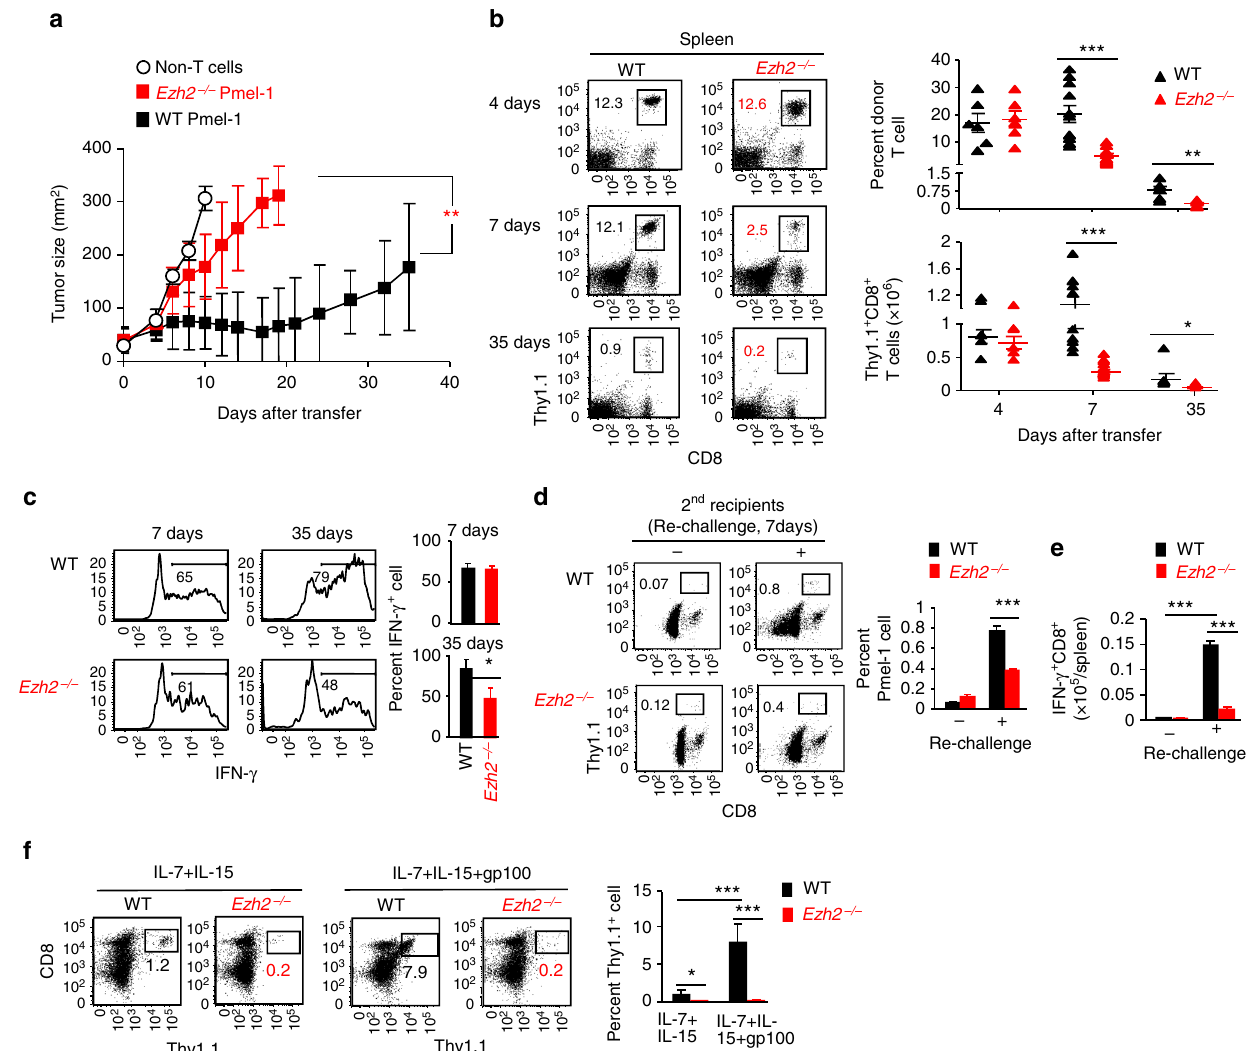
Fig.1 Ezh2 is required for CD8 + T cells to control tumor growth and promote memory precursor formation. a WT and Ezh2 − / − naive Pmel-1 cells (1 × 10 6 , Thy1.1 + ) were transferred into sublethally irradiated (5 Gy) B6 mice (Thy1.2 + ) that had pre-established B16 melanoma, followed by treatment with IL-2 (1 ×